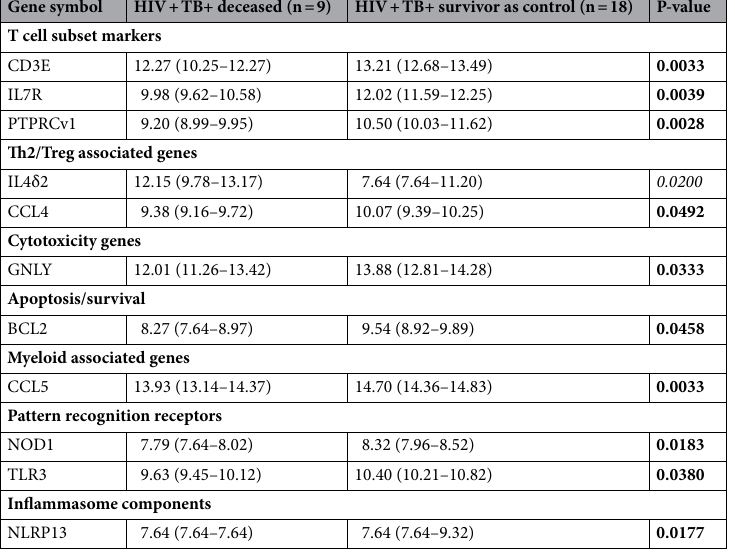
Table 1. Gene expression profiles in deceased groups and survived controls. Median (interquartile range) gene expression values (peak areas normalized for GAPDH and log2-transformed) are shown at the baseline of the death groups and controls, and significant differences between the death groups and controls were determined using the Wilcoxon Mann–Whitney test. In italics: genes are indicated that were more highly expressed in the test group compared to the reference/control group. In bold: genes are indicated that had lower expression in the test group compared to the reference/control group. Only genes whose expression level significantly differed between the two study groups are